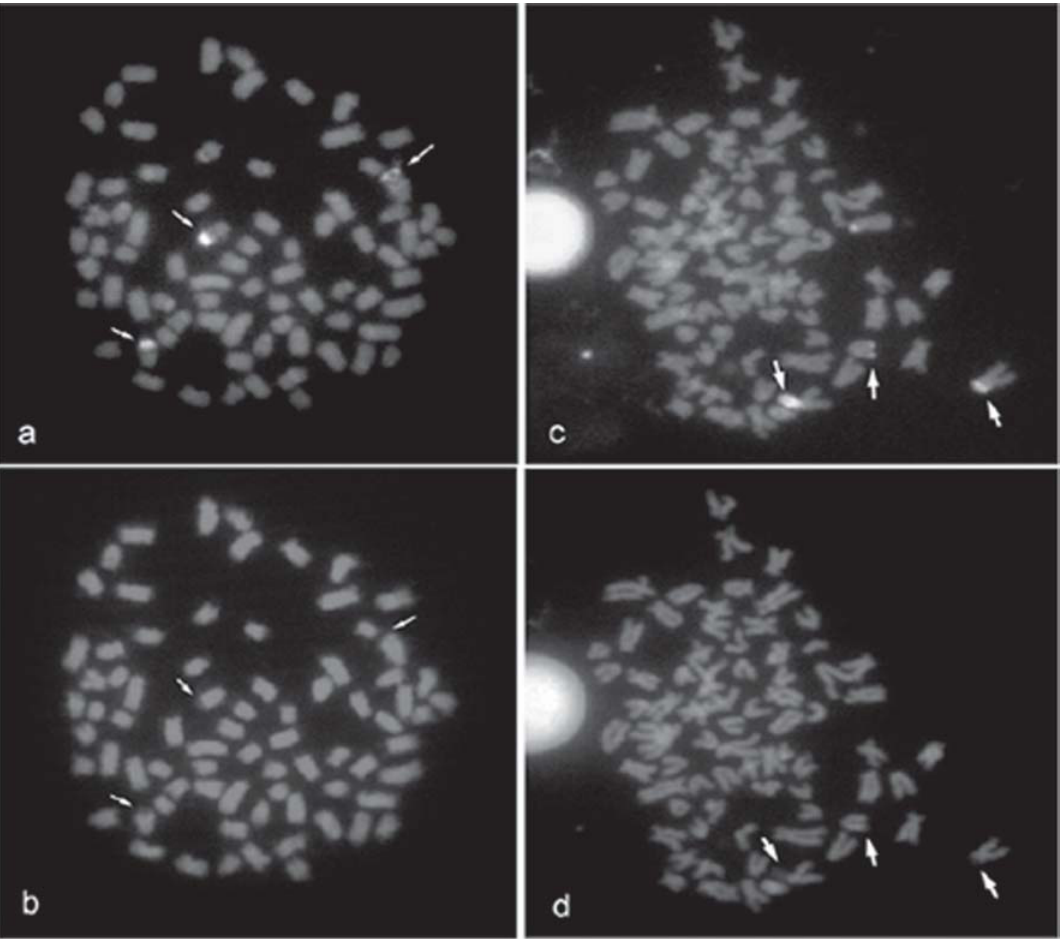
and DAPI, respectively. a) and b) : Mogi-Guaçu; c) and 3